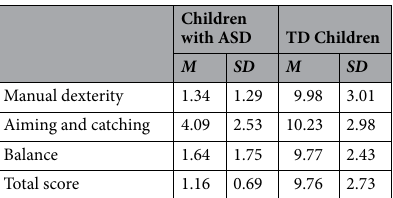
Table 1. Means and Standard Deviation of the MABC-2 scaled scores by group.